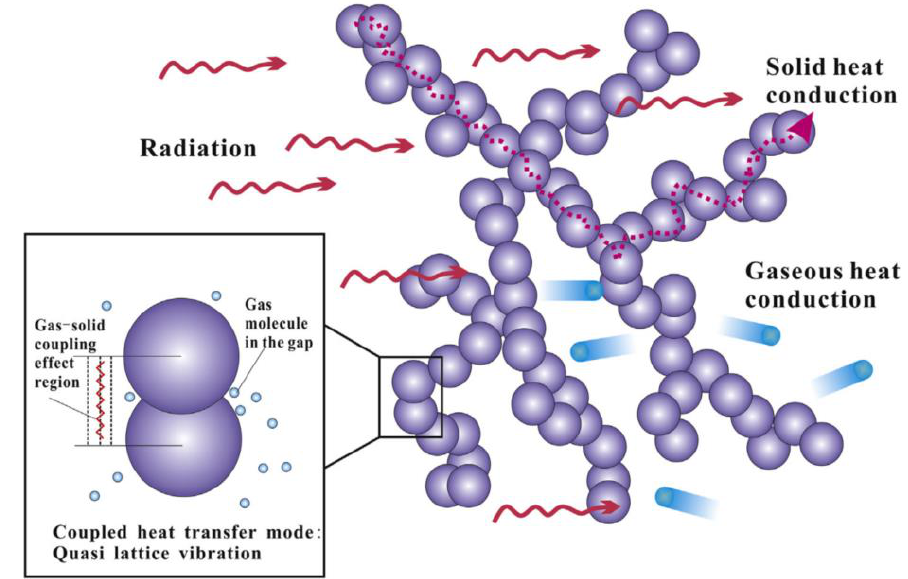
Figure 3. Heat transfer modes of aerogel insulation materials.